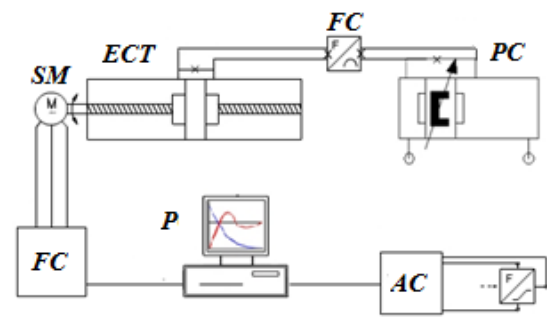
Figure 3. Structural diagram of the friction force test stand in a rodless pneumatic